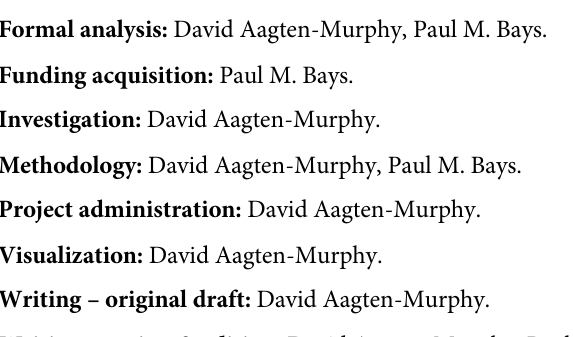
TRIEVE (B) and LM-PRESENT (C) conditions (with LM-ABSENT shown on the right in blue). There was no apparent influence of the visual landmark when it was only visible during response (LM-RETRIEVE). Predictions of the best-fitting model are overlaid. S2 Fig. Meta-analysis of cost parameter estimates. (A) Histogram of estimates of cost (propor- tionate decrease in P ) due to presence of the landmark in Experiments 2, 2B and 3 (based on ego LM-PRESENT and LM-ABSENT conditions; all set size 4). (B) The mean cost (red) across par- ticipants is compared to the proportionate change in P associated with doubling the number ego of memory items (Exp 1). Under the hypothesis of shared resources, these estimates should be equal. Instead, the mean cost of adding a landmark is small in magnitude compared to increas- ing set size, and in the opposite direction (i.e. a minor benefit of the landmark). S3 Fig. Experiment one. (A-C) Average bias (+ve, CW) in location recall for set sizes 1, 2 and 4 respectively, with the best fitting model overlaid. There were no consistent biases related to distance from the landmark. S4 Fig. Experiment two. Parameter estimates for the best-fitting model. Parameters for ego- centric precision (A) and lapse rate (D) were common to all three conditions, while the best fit- ting model for LM-Encode had no allocentric components. While there was no difference in the maximum allocentric precision between LM-GAP and LM-PRESENT (B), there was a small difference in the allocentric scale (C). S5 Fig. Experiment three. Parameter estimates for the best-fitting model. Parameters for ego- centric precision (A) and lapse rate (D) were common to all three conditions. While parame- ters for maximum allocentric precision were shared between LM-GAP and LM-PRESENT, the maximum allocentric precision in the LM-SHIFT condition was decreased (B). The three con- ditions were best fit with differing allocentric scale parameters